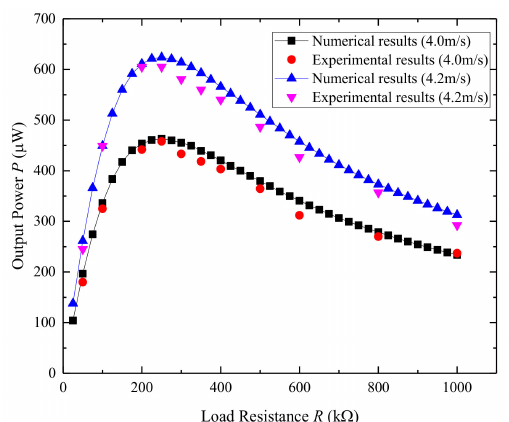
Figure 3. Numerical results and experimental results of average output power P versus load resistance R.